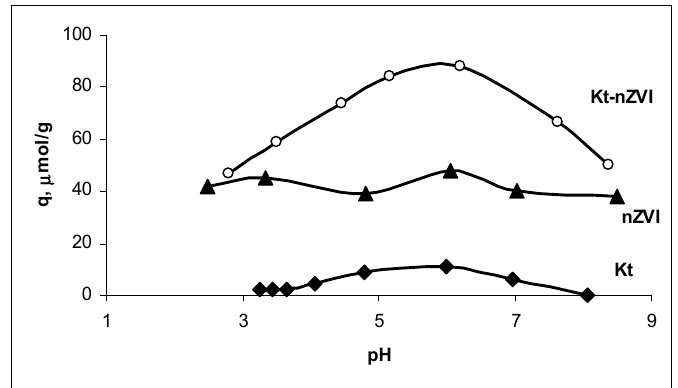
Figure 4. Sorption of U(VI) ions on pristine kaolinite and kaolinite-nZVI as a function of pH.